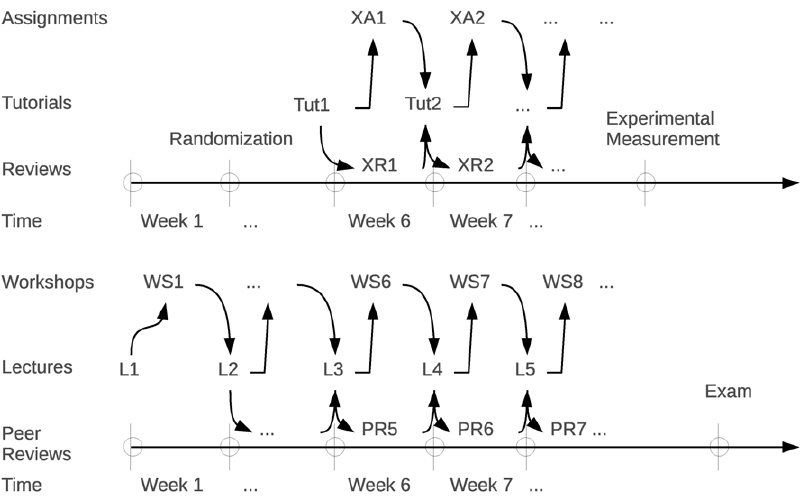
Figure 2. Schedule of experimental learning activities.